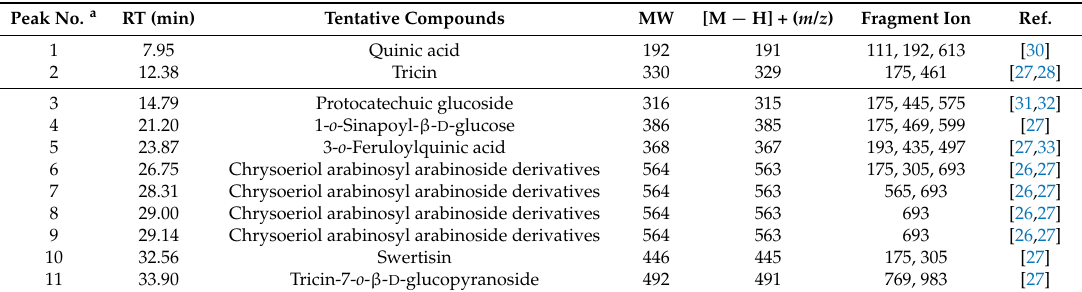
Figure 2. Reversed-phase Ultra High-Performance Liquid Chromatography with diode array detection (UHPLC-DAD) chromatogram of Thai ricegrass juice extract ( Oryza sativa ., Chainat1) with identified peak (1–11). Table 1. Tentative identification of phenolic compounds in ricegrass juice extract analyzed by Ultra High-Performance Liquid Chromatography with electrospray ionization-mass spectrometry